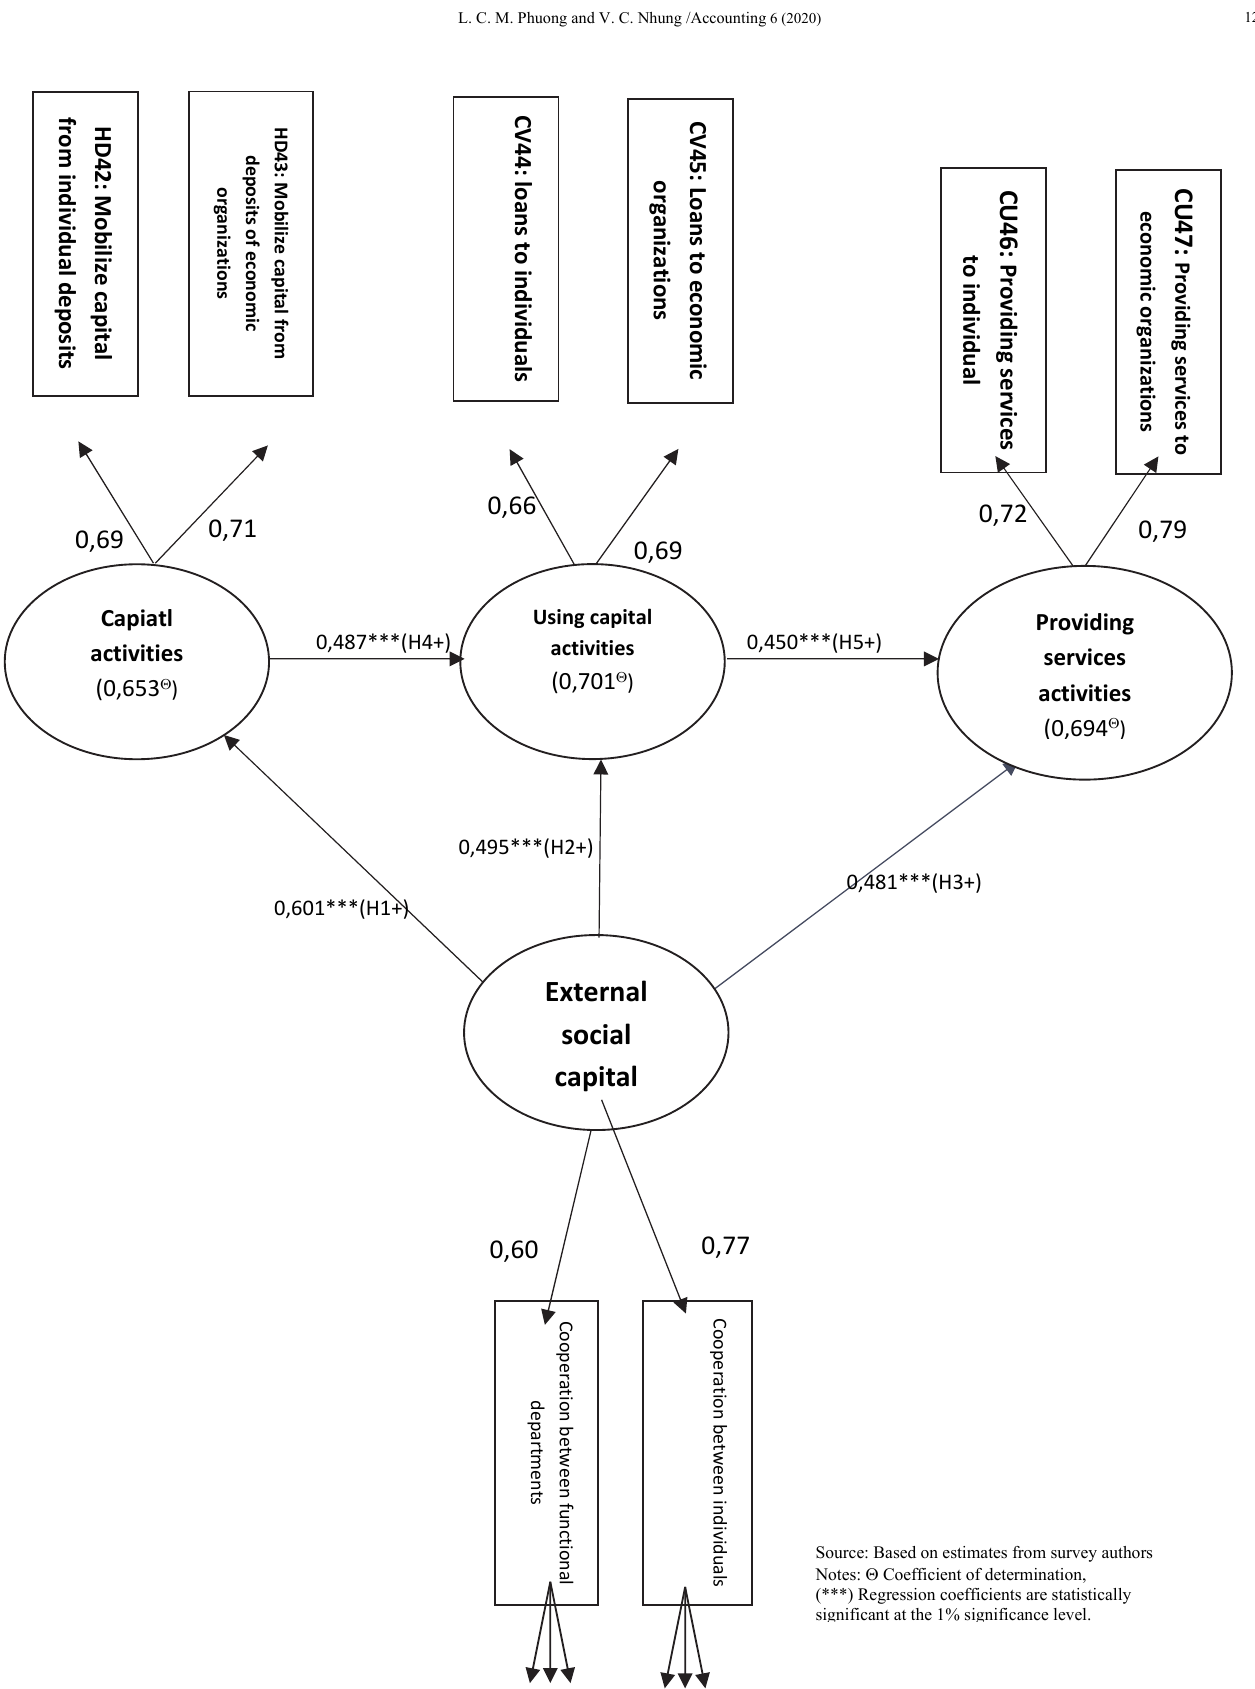
Fig. 3. SEM results of the research model